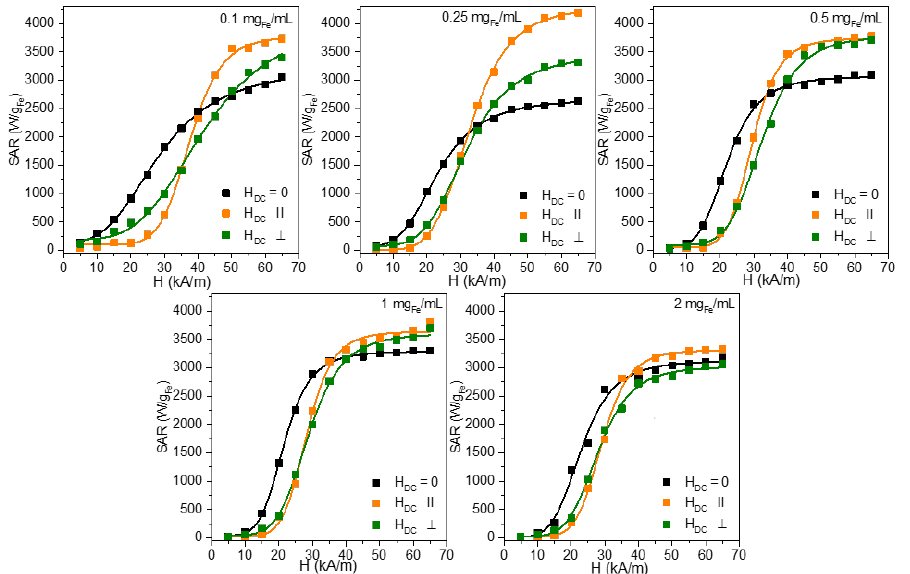
Figure 3. SAR dependence on the H for both the parallel or perpendicular orientations of the H DC (10 kA/m) to the AMF lines for Zn ferrites dispersed in water in the concentration range 0.10–2.00 mg Fe /mL. For comparison, the SAR dependence on the H for all samples in zero H DC is also plotted. Table 4. SAR max , H cHyp, and n for the samples measured in water under H DC of 10 kA/m. H DC Parallel Concentration (mg Fe /mL)